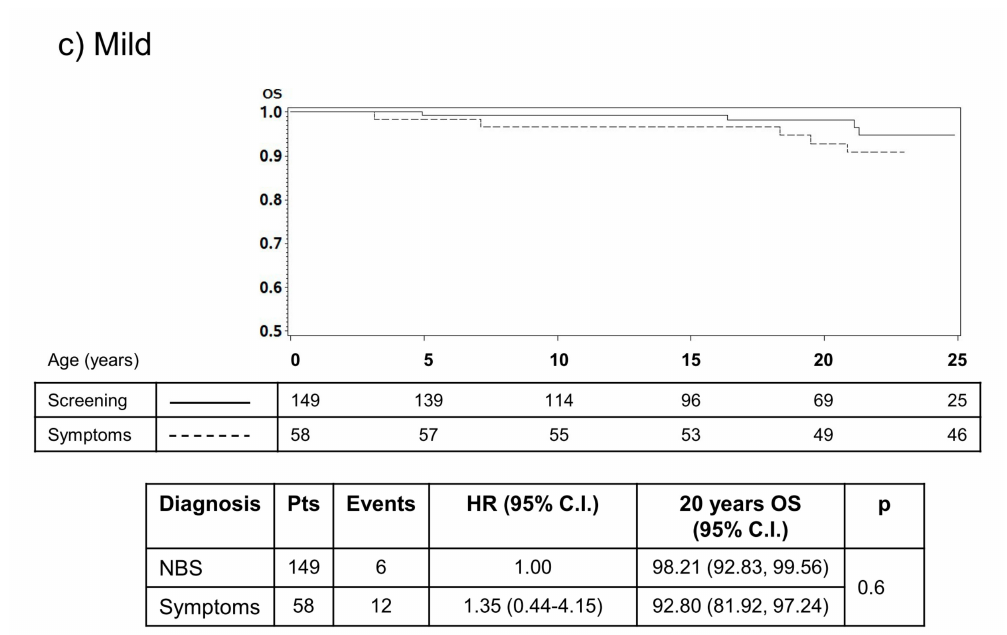
Figure 1. Results from an Italian study that illustrates the impact of early diagnosis through NBS on survival. The impact on survival is most apparent in infants with severe ( a ) or moderate disease ( b ) after diagnosis, highlighting the reduced impact of early diagnosis on people with mild or less typical CF ( c )